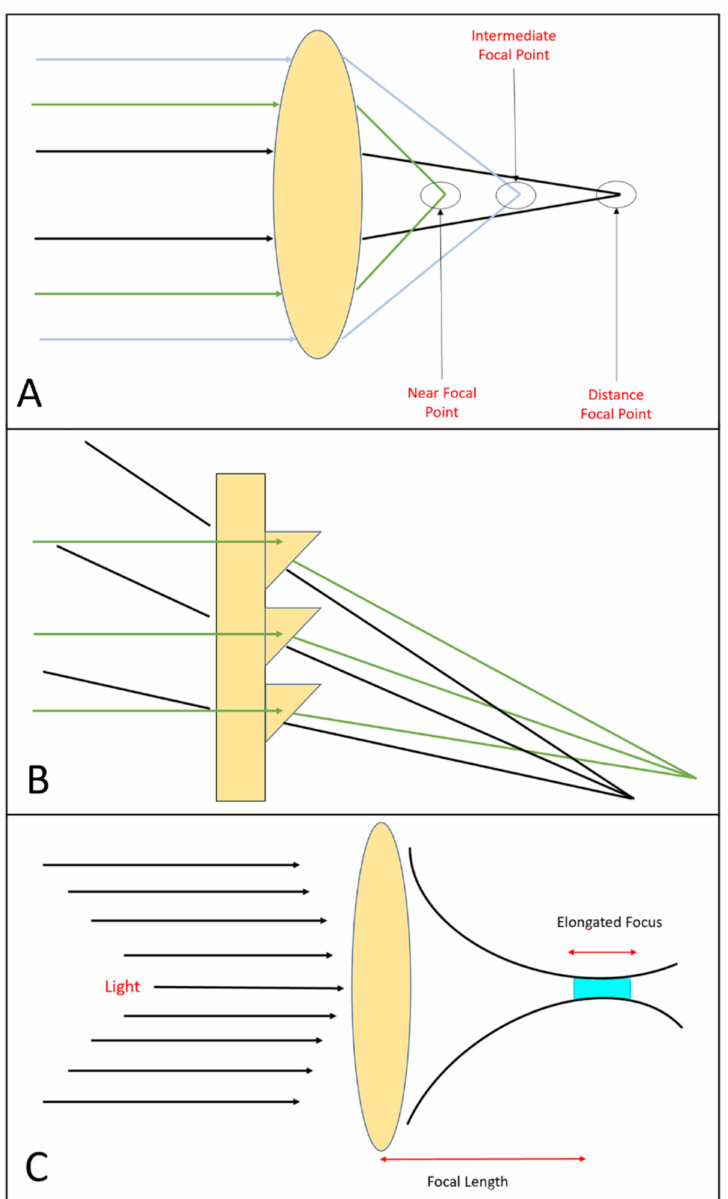
Figure 1. ( A ) Refractive lens design with three zones that concentrates light rays from the intermediate distance (light blue arrows), near distance (green arrows) and far distance (black arrows). ( B ) Image showing the principle of a diffractive lens. Light travels slower on the side of the step of the lens compared to the speed of light moving through the aqueous area, resulting in two foci: one for near vision and one for far vision. ( C ) Extended depth-of-focus (EDoF) lens design, which works by creating a single elongated focal point rather than several focal points to enhance the depth of